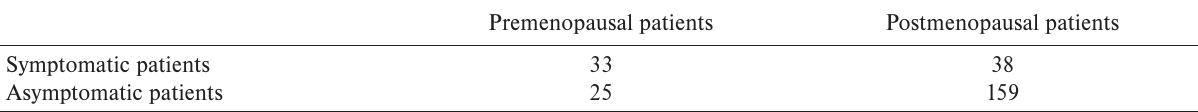
Table 2. Symptoms and menopause status.